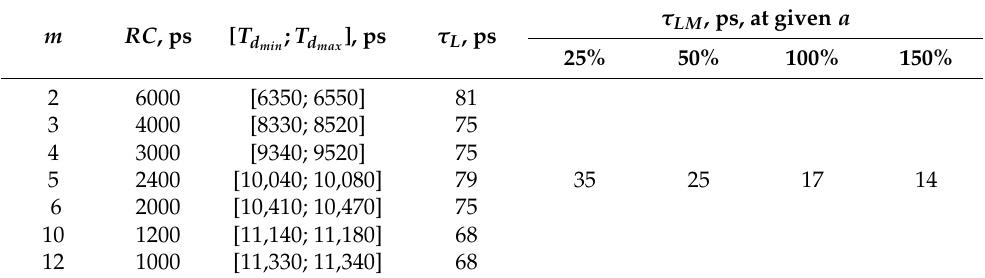
Table 4. Laser pulse durations τ L and τ LM in the SSHML regime with and without modulation (numerical